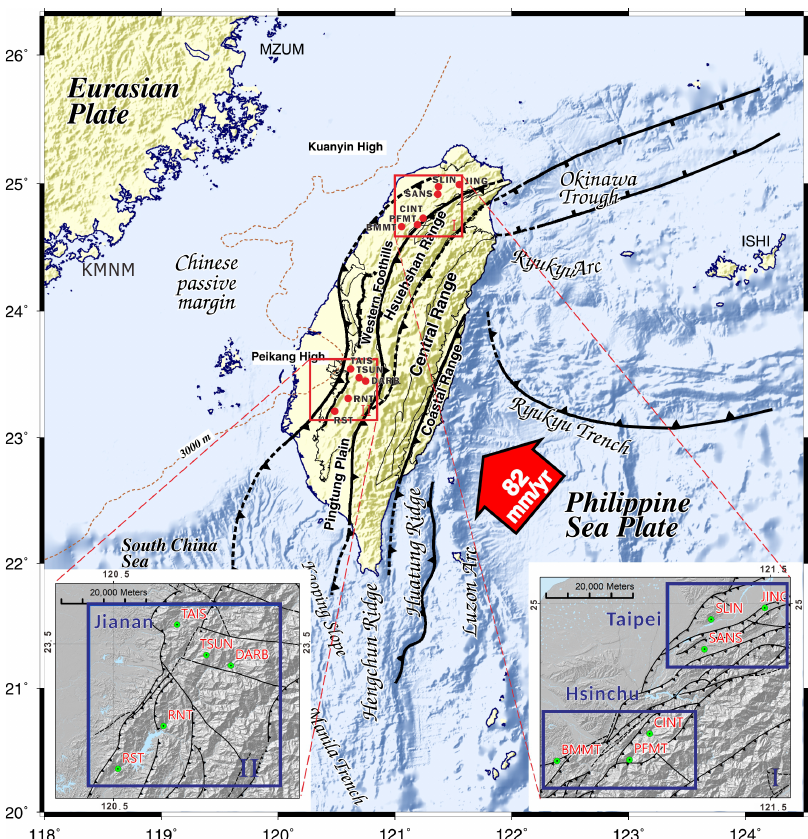
Figure 1. Tectonic map and locations of installed borehole strainmeters in this study (red circles). Subduction along the Ryukyu and Manila trenches shown as a solid line with triangles to the overriding plate. Red arrow represents directions and convergence rate between the volcanic and continental margin. Installed borehole strain meter (BSM) divided into three networks (show as blue block in the bottom diagrams). Major faults are shown in the small diagrams. Relief map in the vicinity of the borehole strainmeters discussed in this paper is shown in the Figure S1.